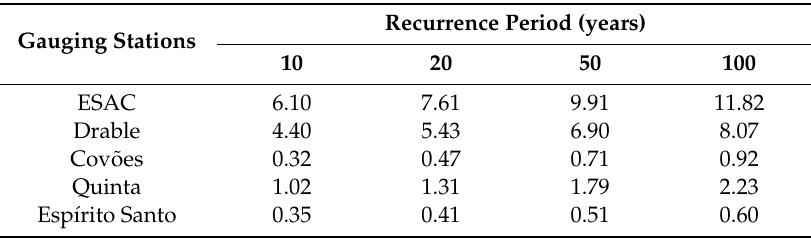
Table 5. Estimated peak discharge (m 3 / s) at the outlet (ESAC) and at the four upstream gauging stations for 10–, 20–, 50– and 100–year floods in the Ribeira dos Cov õ es catchment. Gauging